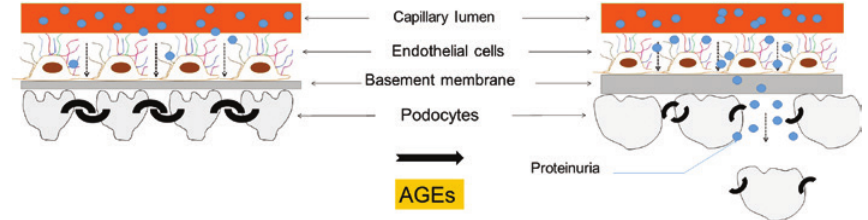
Figure 5: Illustration of the comprehensive effect of AGEs on the glomerular architecture. AGEs induce thickening of the glomerular basement membrane, hypertrophy of podocytes and podocyte epithelial-mesenchymal transition. These events account for the altered structure of the glomerular filtration barrier and reduced podocyte count that ultimately manifest in